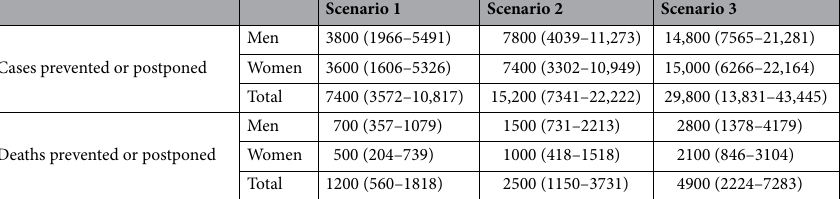
Scenario 1 Scenario